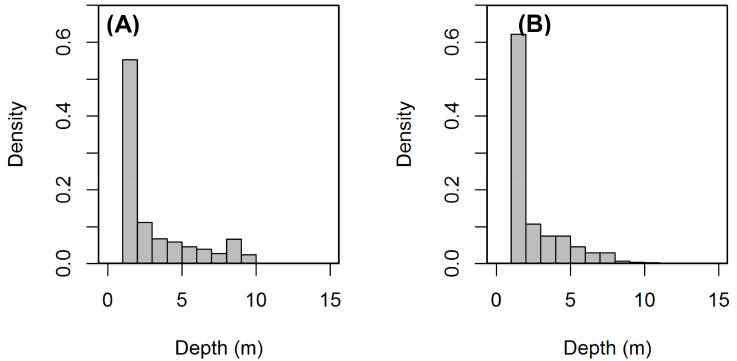
Figure A2. Histogram comparing MIKE11 hydrodynamic model simulation of a large-scale flood event ( A ) versus the TIN estimation from this study ( B ). For the purposes of this comparison, TIN estimations less than one meter were binned up to one meter to match the MIKE11 convention.